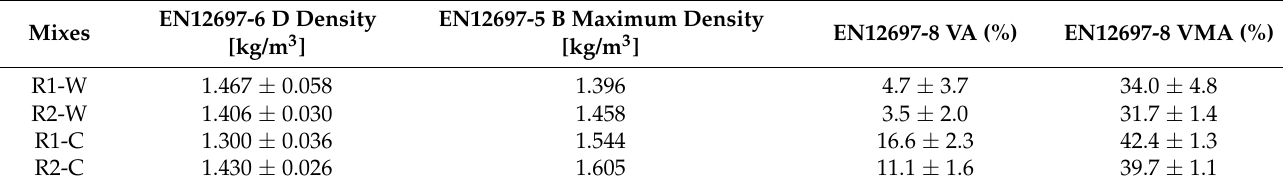
Table 2. Densities and air voids of the produced specimens.